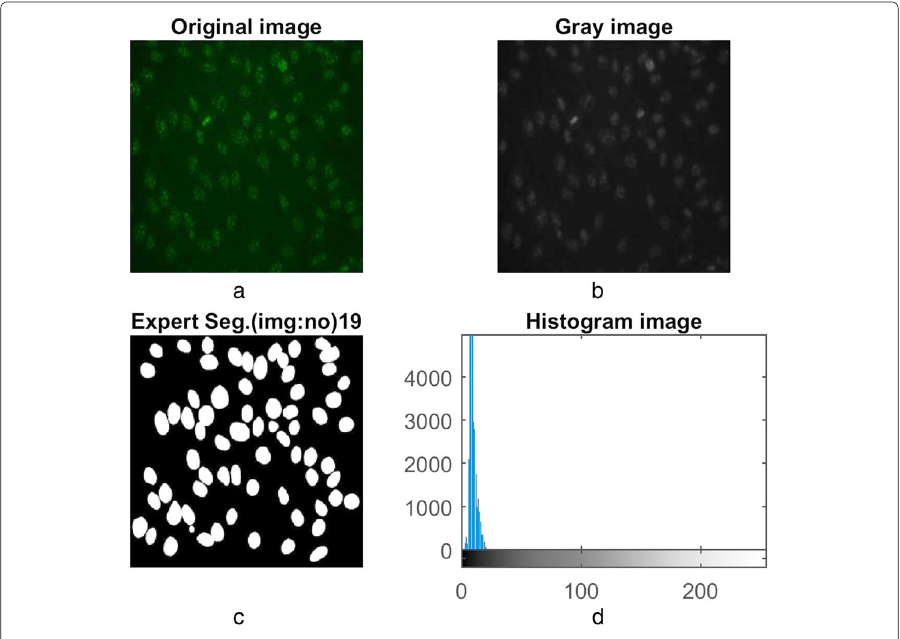
Fig. 7 a Original image. b Its gray level. c Expert segmentation. d Image histogram